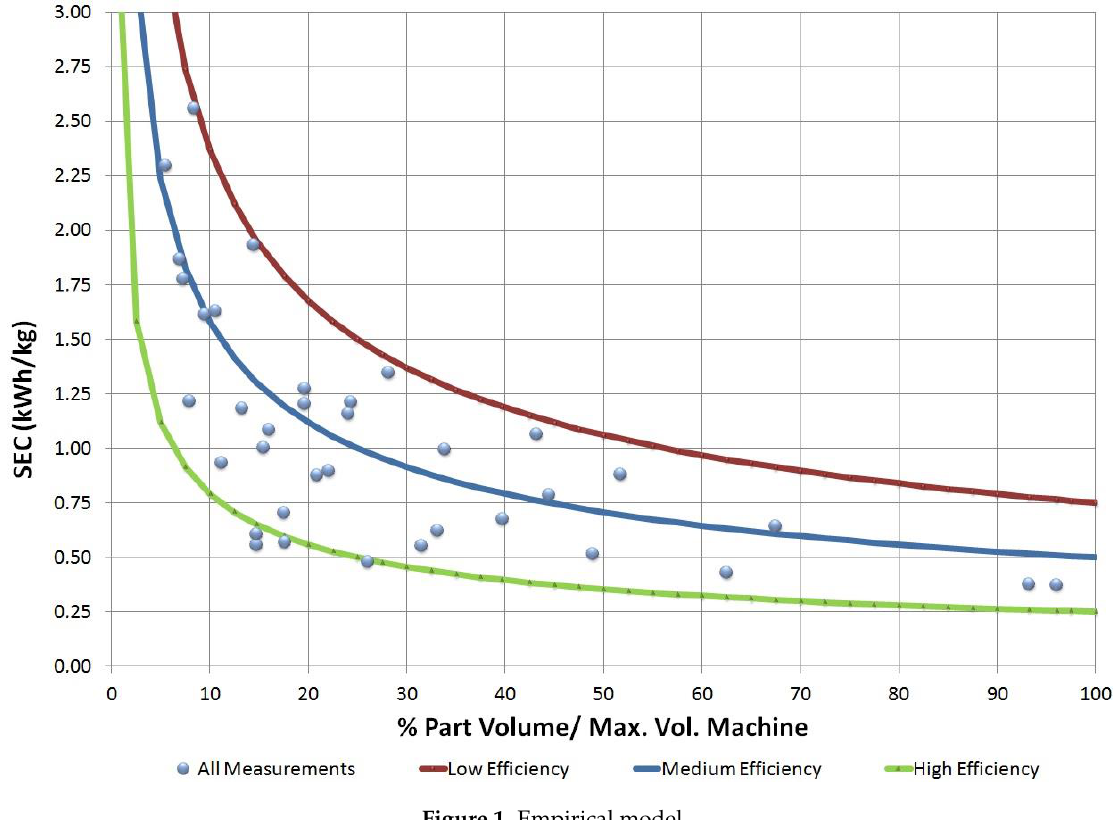
Figure 1. Empirical model.